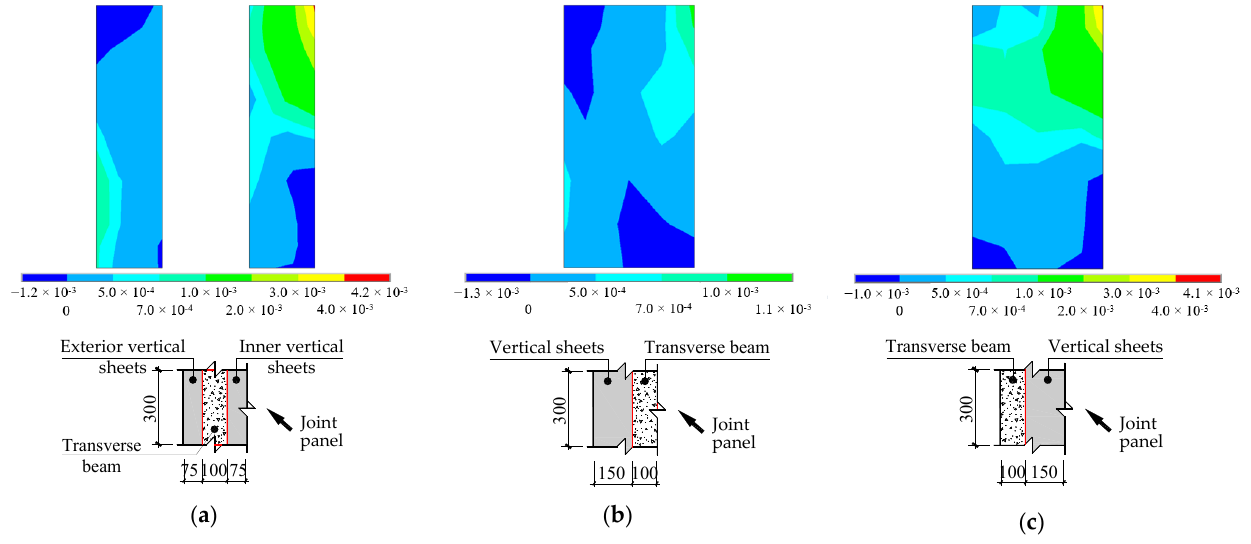
Figure 11. Distributions of longitudinal strains in vertical CFRP sheets (positive and negative values indicate tensile and compressive strain, respectively). ( a ) Specimen DMv1030; ( b ) Specimen DIv1030; ( c ) Specimen DEv10.